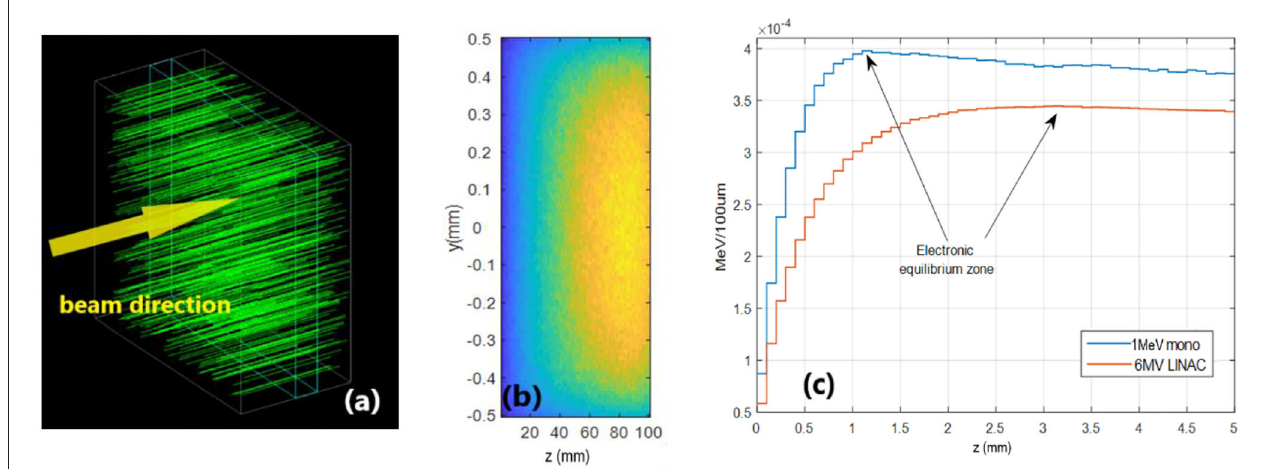
FIGURE 4 | (a) View of the geometry used for the Monte Carlo simulation. (b) Projection in the yz plane of the energy deposited by the 1 MeV photon beam in the sensor. (c) Average deposited energy per photon in 100 µ m slices as a function of the depth z in the silicon. Results are shown both for monoenergetic 1 MeV photons and for a photon beam with the energy spectrum of a 6MV LINAC. The arrows point to the depth where the electronic equilibrium is